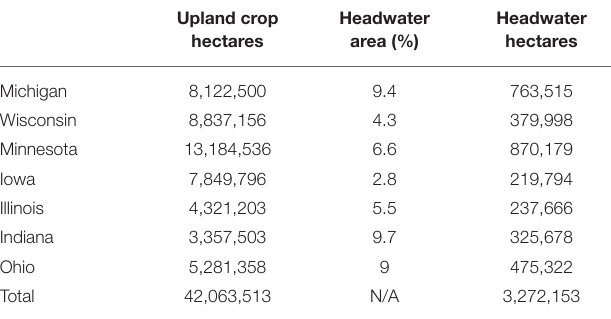
TABLE 1 | Upland crop hectares with headwater percentage and area